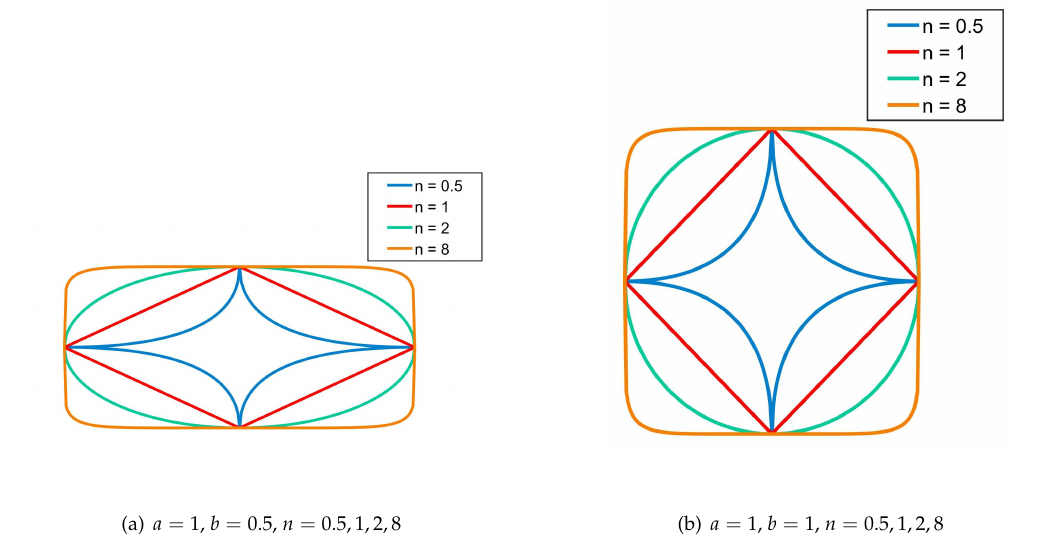
Figure 3. Two special cases with the different parameters in Equation